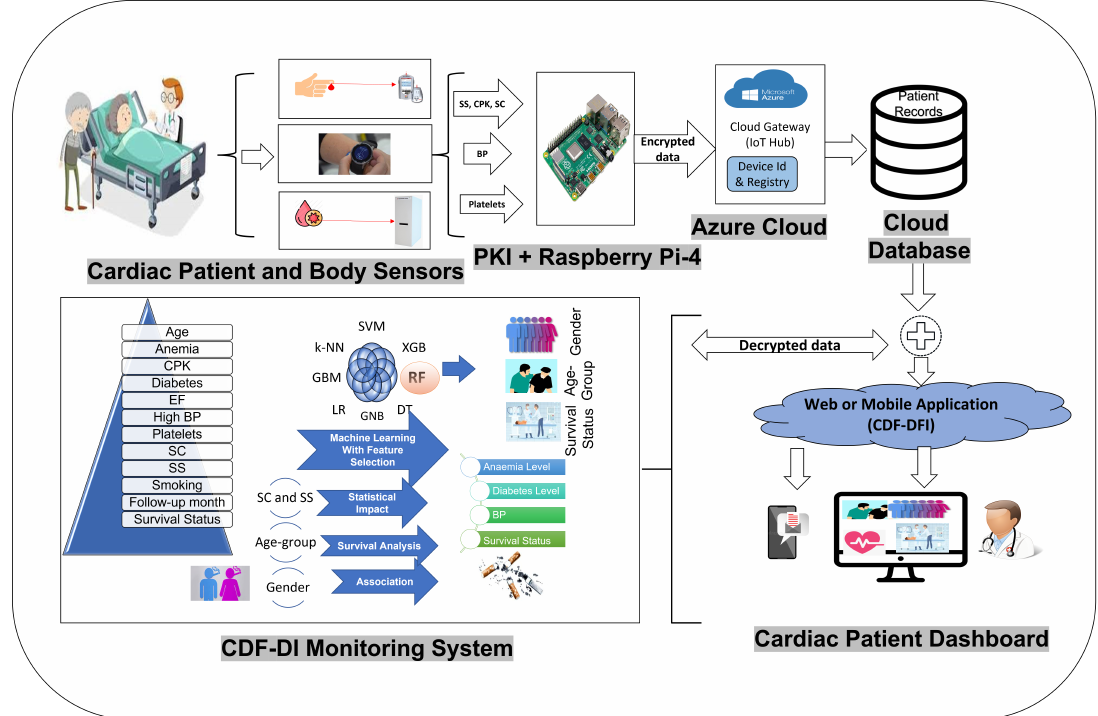
Figure 1. Conceptual Design of CDF-DI integration with IoT